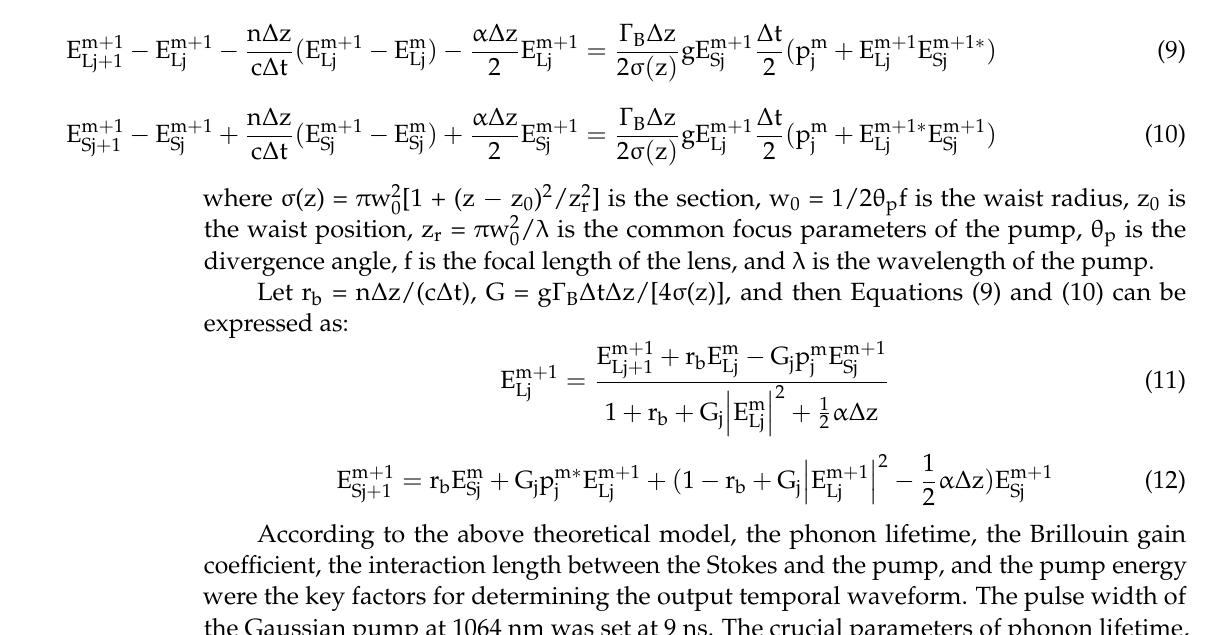
Table 1. Changes in four key parameters: phonon lifetime, Brillouin gain coefficient, the interaction length between the Stokes and the pump, and pump energy. Phonon Lifetime (ns) 0.1 to 2.1 Brillouin gain coefficient (cm/GW) 0.1 to 0.5 Interaction length between the Stokes and the pump (cm) 5 to 45 Pump energy (J) 0.5 to